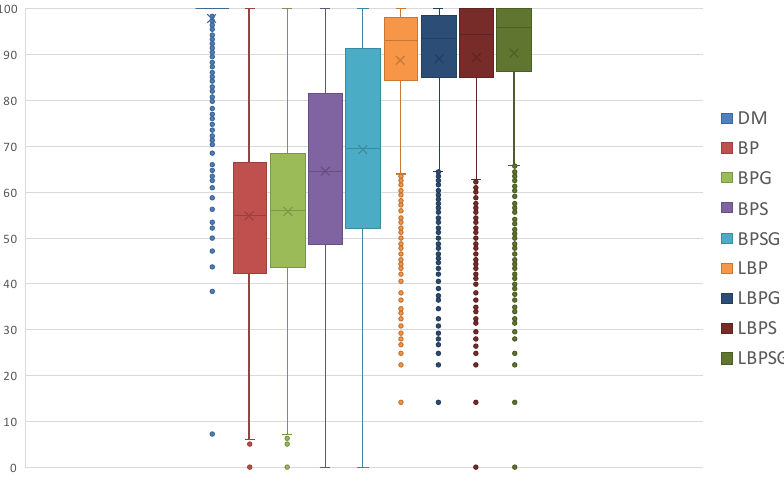
Figure 10. BP and LBP variants: LO jobs scheduled per task set in HC-LP scenario.